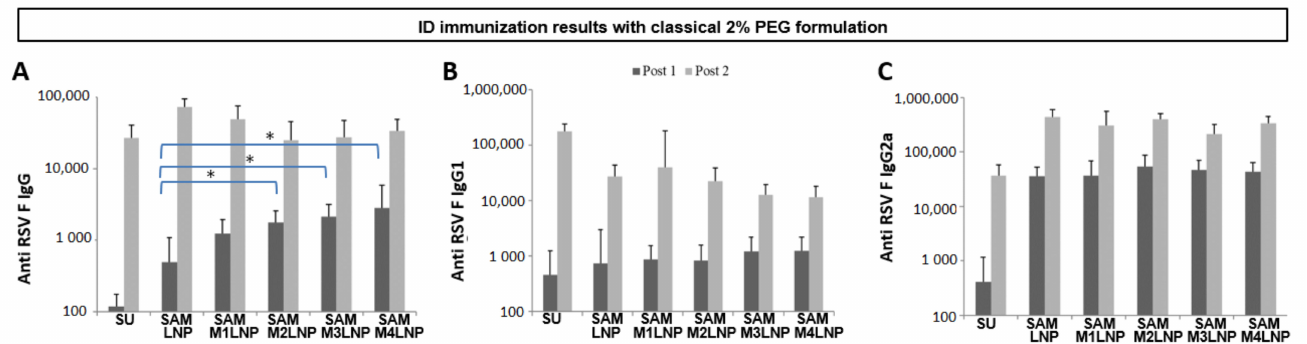
Figure 4. Immunization titers of RSV F SAM antigen formulated with classical 2% PEG LNP and MLNP formulations and administered through ID route. Median IgG ( A ), IgG1 ( B ), and IgG2a ( C ) titers, considering non adjuvanted subunit (SU) group as control. * p < 0.05 ( n =